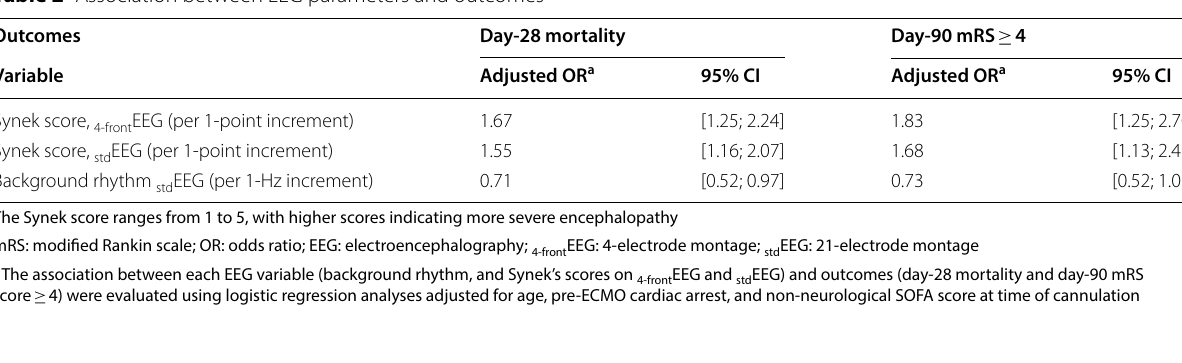
Table 2 Association between EEG parameters and outcomes